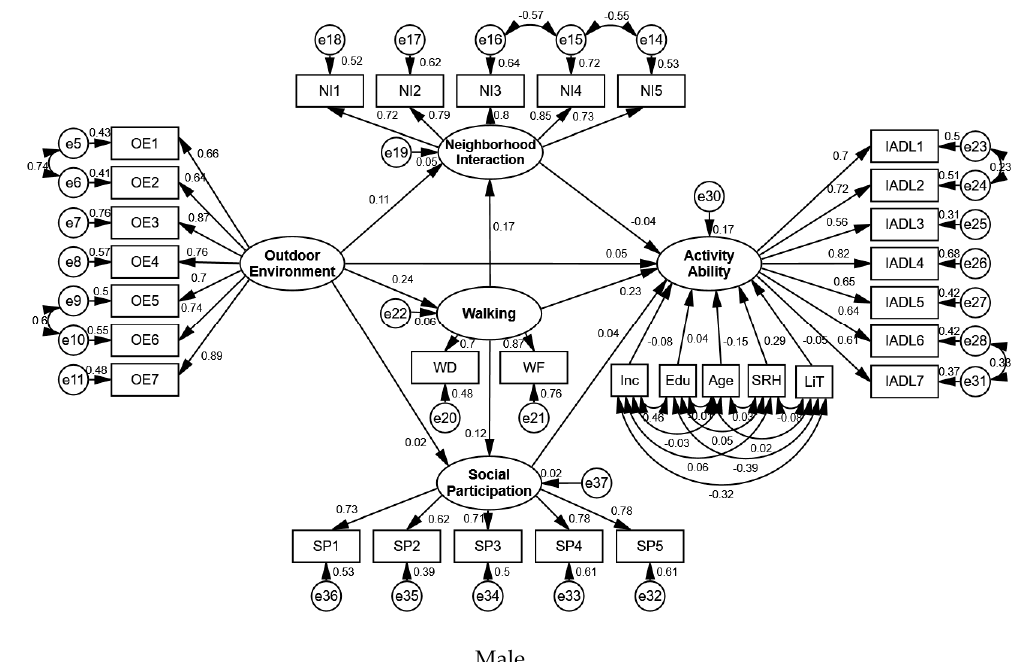
Figure 5. Standardization coefficients for male sample model. Int. J. Environ. Res. Public Health 2020 , 17 , x